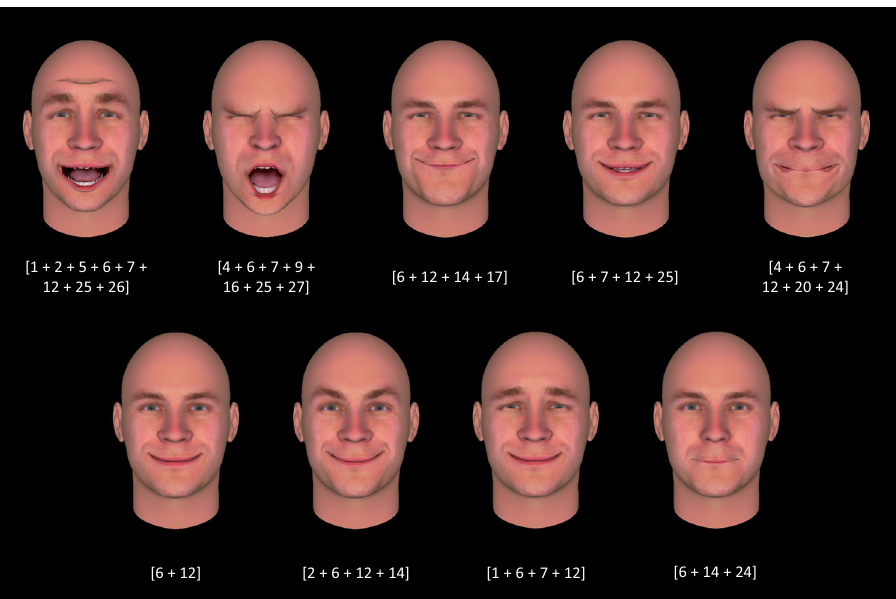
Fig. 2 Facial poses for inductive cluster 68, identi fi ed with unsupervised clustering of Sample 1 participants ’ scenario ratings, with a model-selection procedure based on highest intra-cluster reliability in facial pose action units (AUs). Poses are presented along with their constituent AUs; consistent AUs for this cluster were 6, 7, and 12. These AUs occur in hypothesized facial con fi gurations associated with happiness and amusement (Supplementary Table 1). However, the above facial poses depict con fi gurations that were identi fi ed in photographs of actors portraying scenarios that evoked a variety of emotion categories. The associated emotion categories for the scenarios in this cluster (based on participants ’ ratings) were happiness, interest, pride, and surprise. Facial con fi gurations were created in FaceGen (Singular Inversions, Inc., Toronto, ON, CA), with AUs set to 100% intensity, except where this would yield visible distortions — in those cases, AUs were set to 80% intensity. Source data are provided in Supplementary Table